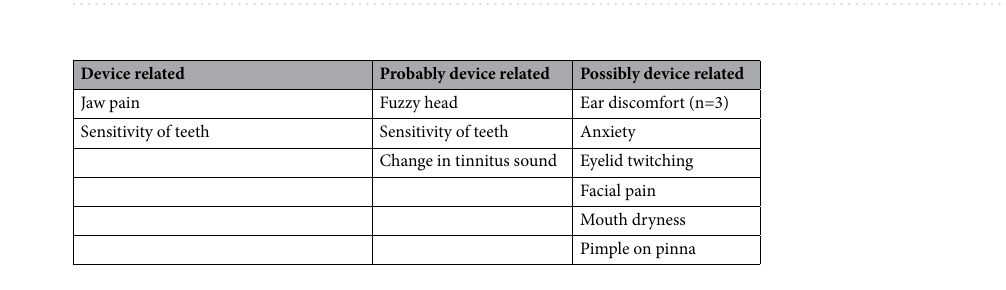
Table 4. Unanticipated treatment related AEs listed in Table